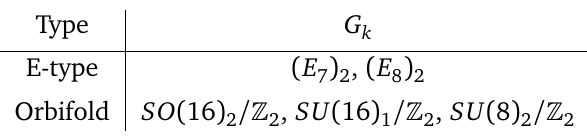
Table 2: List of WZW models whose (cid:90) orbifold allows fermionization to supersymmetric mod- 2 els. However their Ramond vacua do not saturate the supersymmetric unitarity